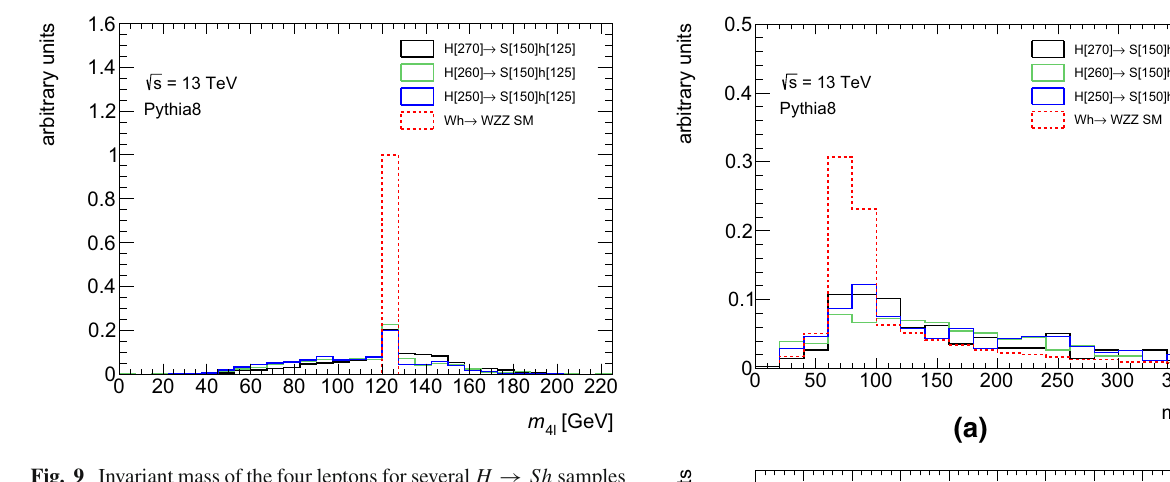
Fig. 9 Invariant mass of the four leptons for several H → Sh samples (solid lines) compared with the SM Wh process with h → Z Z → 4 (cid:4) (dashed line) generated with PYTHIA8 . The last bin contains overflow events